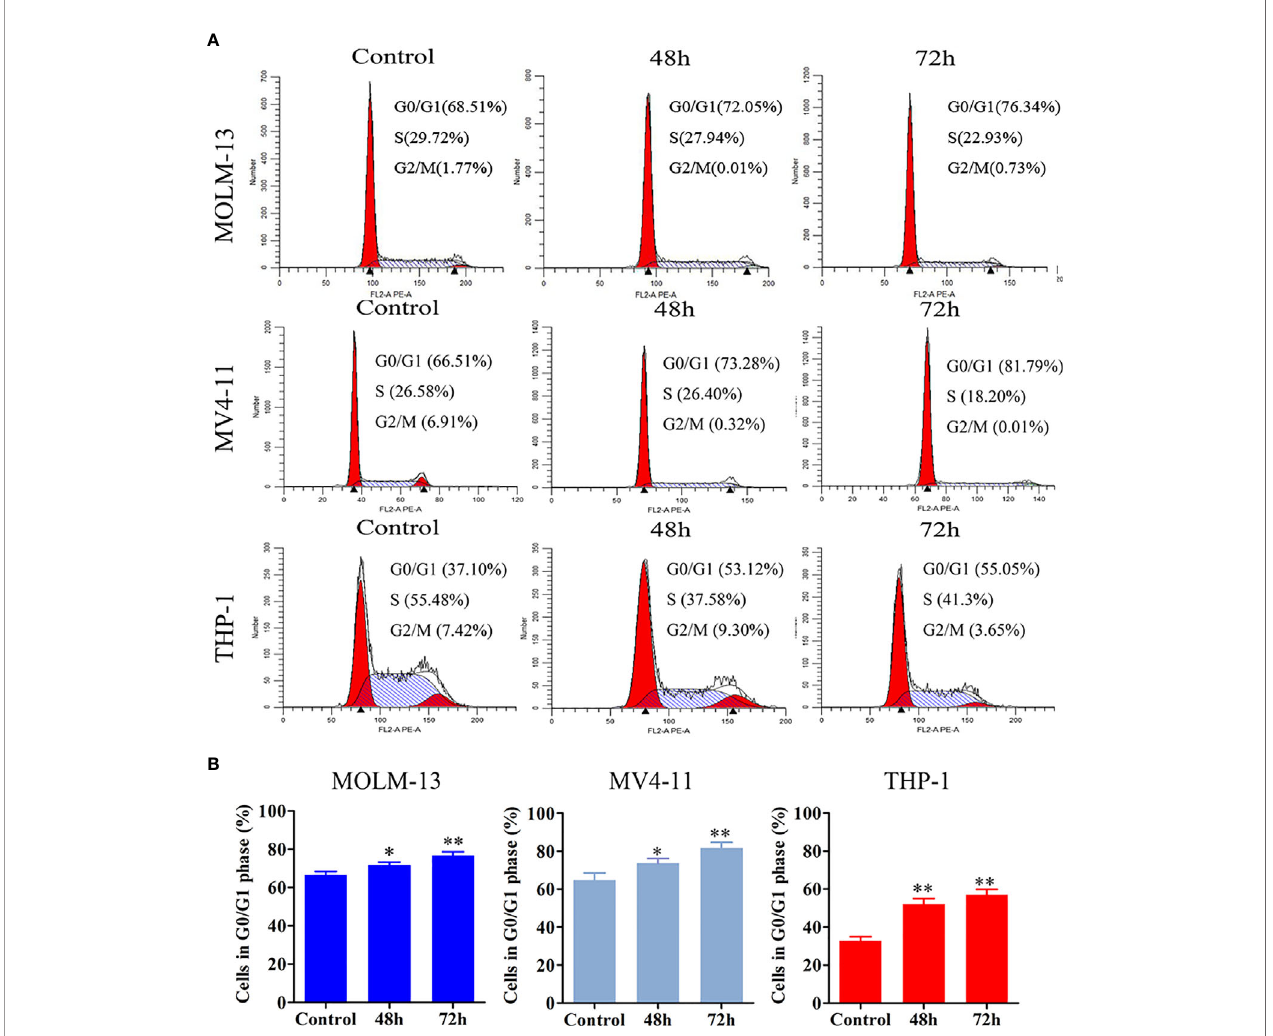
FIGURE 3 | JOA induces cell cycle exit in MV4-11, MOLM-13 and THP-1 cells. (A) MV4-11, MOLM-13 and THP-1 cells were treated with 0.5, 0.5 or 2 m M JOA, respectively for 48 h or 72 h, then fl ow cytometry was used to detect the percentage of cells in various phase of the cell cycle. (B) Graph bars show the percentage of cells in G0/G1 phase. (*p < 0.05, **p < 0.01). The cell cycle analysis was performed for four